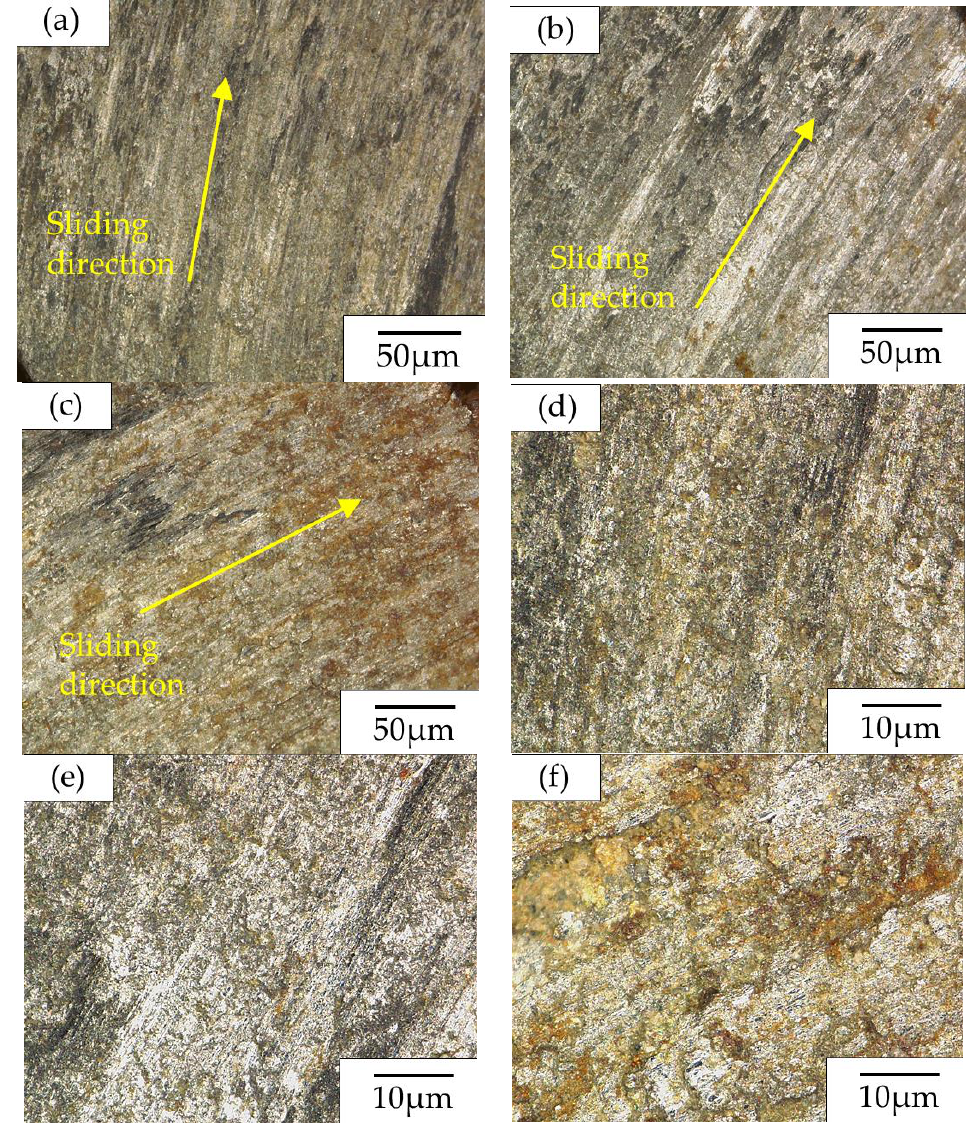
Figure 9. Micro morphologies of worn surfaces of the pin at different soils (5 N, moisture 10%, 450 r/min): ( a , d ) soil of clay; ( b , e ) soil of loam; ( c , f ) soil of sandy.